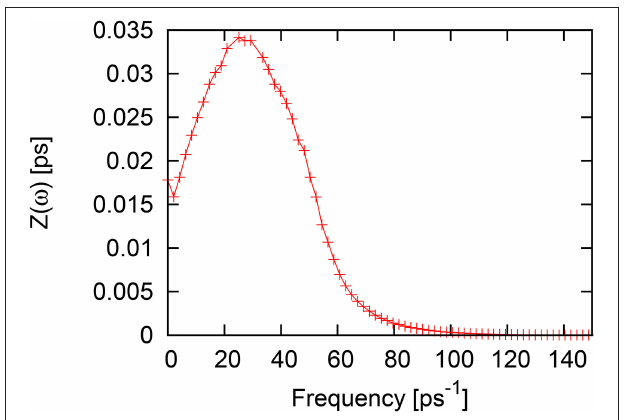
FIGURE 6 | Fourier spectrum of velocity autocorrelation function for liquid Ni.